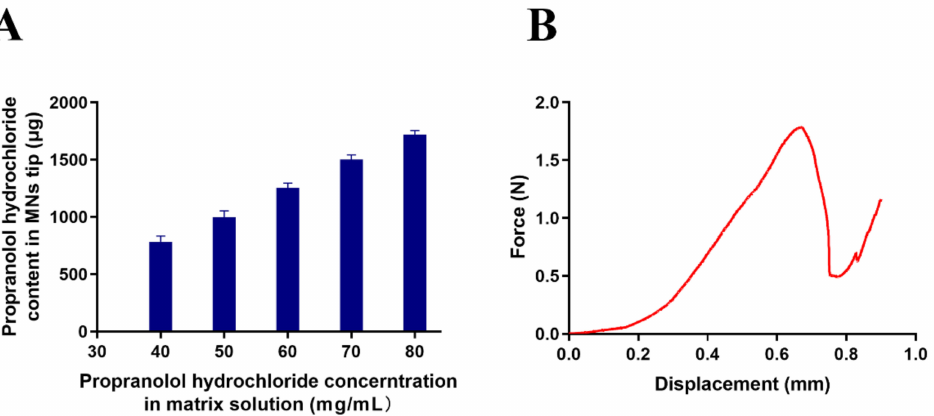
Figure 7. ( A ) Content of propranolol hydrochloride in the MNs was linearly increased with the increase of its content in the tip solution ( n = 3). ( B ) The force-displacement curve of propranolol hydrochloride-loaded dissolving MNs patch.